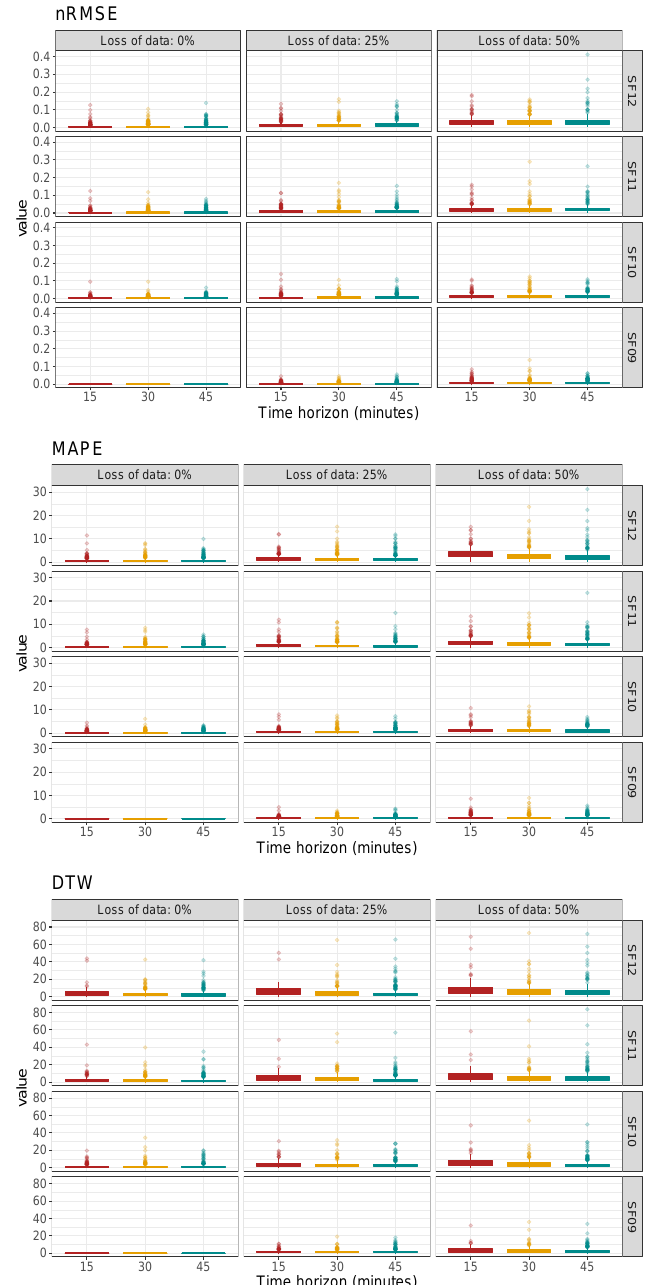
Figure 16. Boxplot of differences based on SF09 and 0% loss of data: nRMSE, MAPE, and DTW